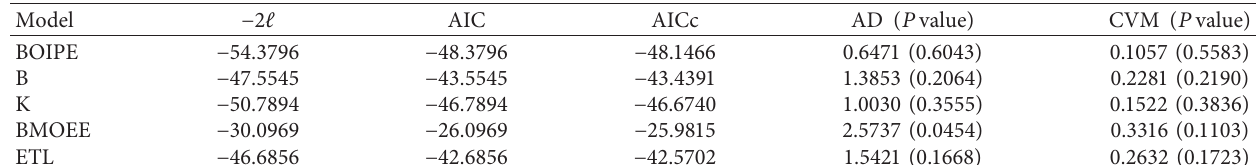
Table 5: Goodness-of-fit statistics for data I.